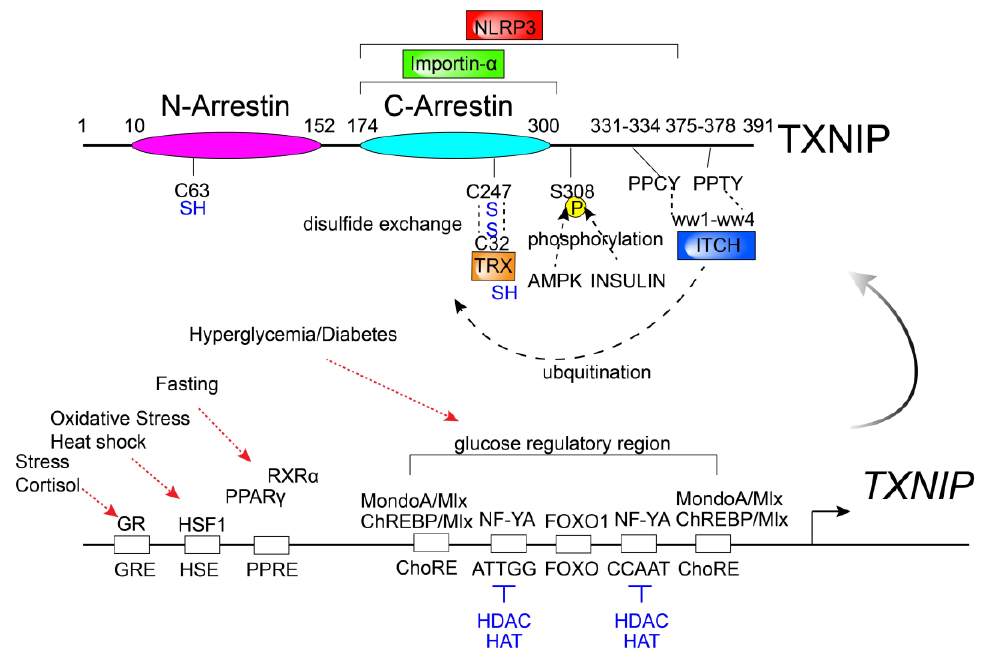
Figure 2. Transcriptional and post-translational modification and protein interacting domains of TXNIP. TXNIP gene expression is regulated by various stimuli. Post-translational modifications and protein interactions of TXNIP influence its protein stability, localization and function in a cellular and context-dependent manner. Protein scaffolding and the biological function of TXNIP are biased in the C-arrestin domain. Two PPxY motifs (PPCY and PPTY) of Txnip bind to the four WW domains of E3 ubiquitin ligase, ITCH. Insulin and AMPK facilitate the protein degradation by serine 308 (S308) phosphorylation of TXNIP. TXNIP forms disulfide bonds with reduced TRX by disulfide exchange through its cysteine 247 (C247). Glucocorticoid–glucocorticoid responsive element (GR–GRE), heat shock factor 1–heat shock element (HSF1–HSE), peroxisome proliferator-activated receptor γ / retinoid X receptor α –peroxisome proliferator-activated receptor element (PPAR γ / RXR α –PPRE), MLX interacting protein / Max-like protein X (MondoA / Mlx – ChoRE) or carbohydrate-responsive element-binding protein / Max-like protein X–carbohydrate response element (ChREBP / Mlx-ChoRE), nuclear transcription factor Y subunit α –CCAAT motif (NF-YA–ATTGG / CCAAT), Forkhead Box O1